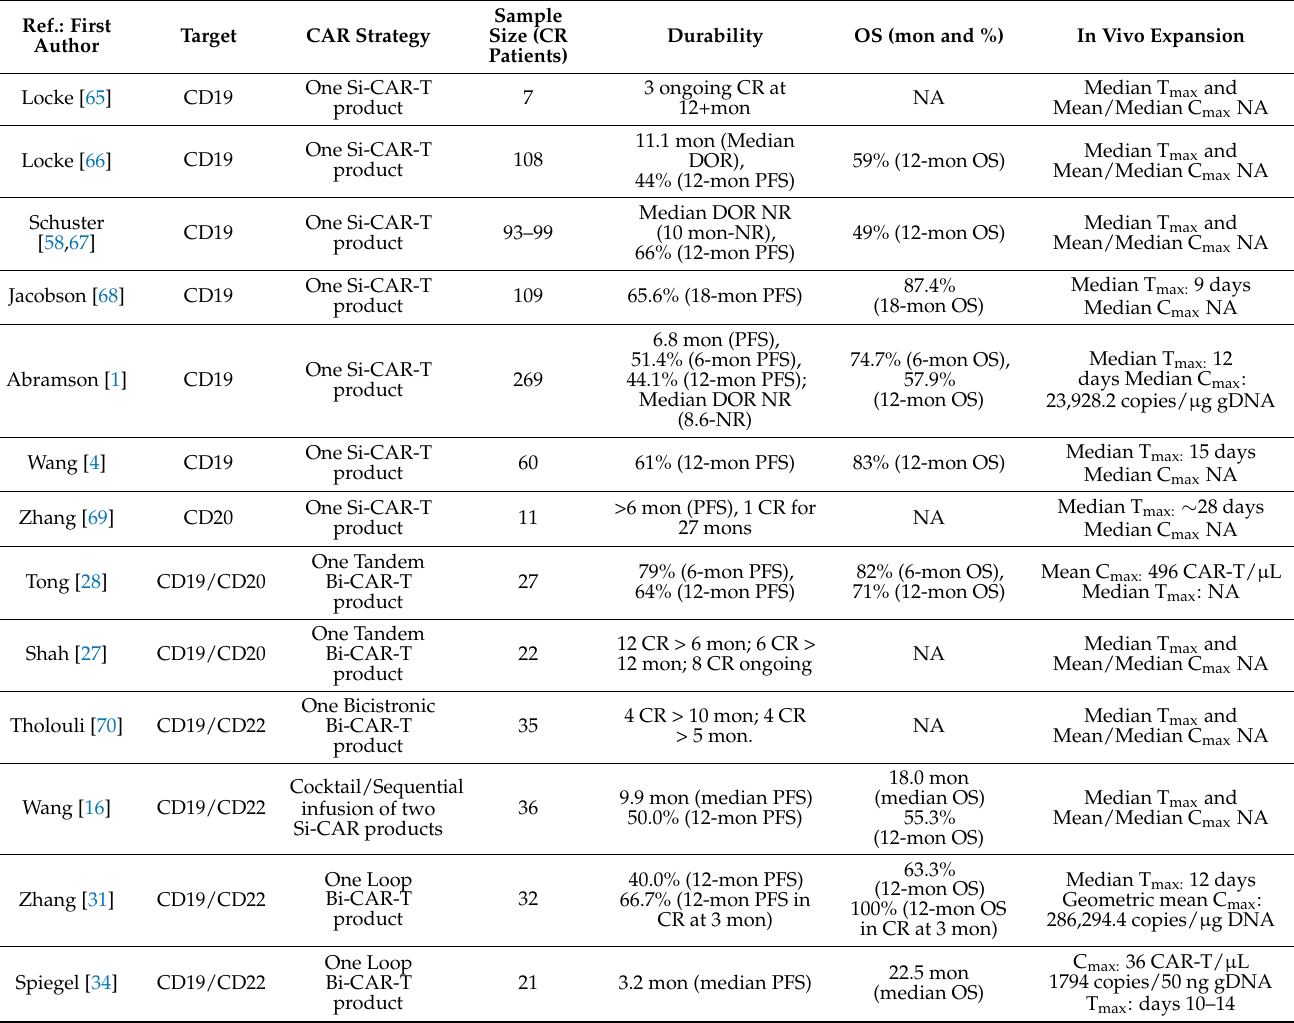
Table 4. Comparison of dual-targeting CD19/CD20 or CD19/CD22 CAR T-cell therapy with the respective Si-CAR- T-cell therapy regarding duration and survival in